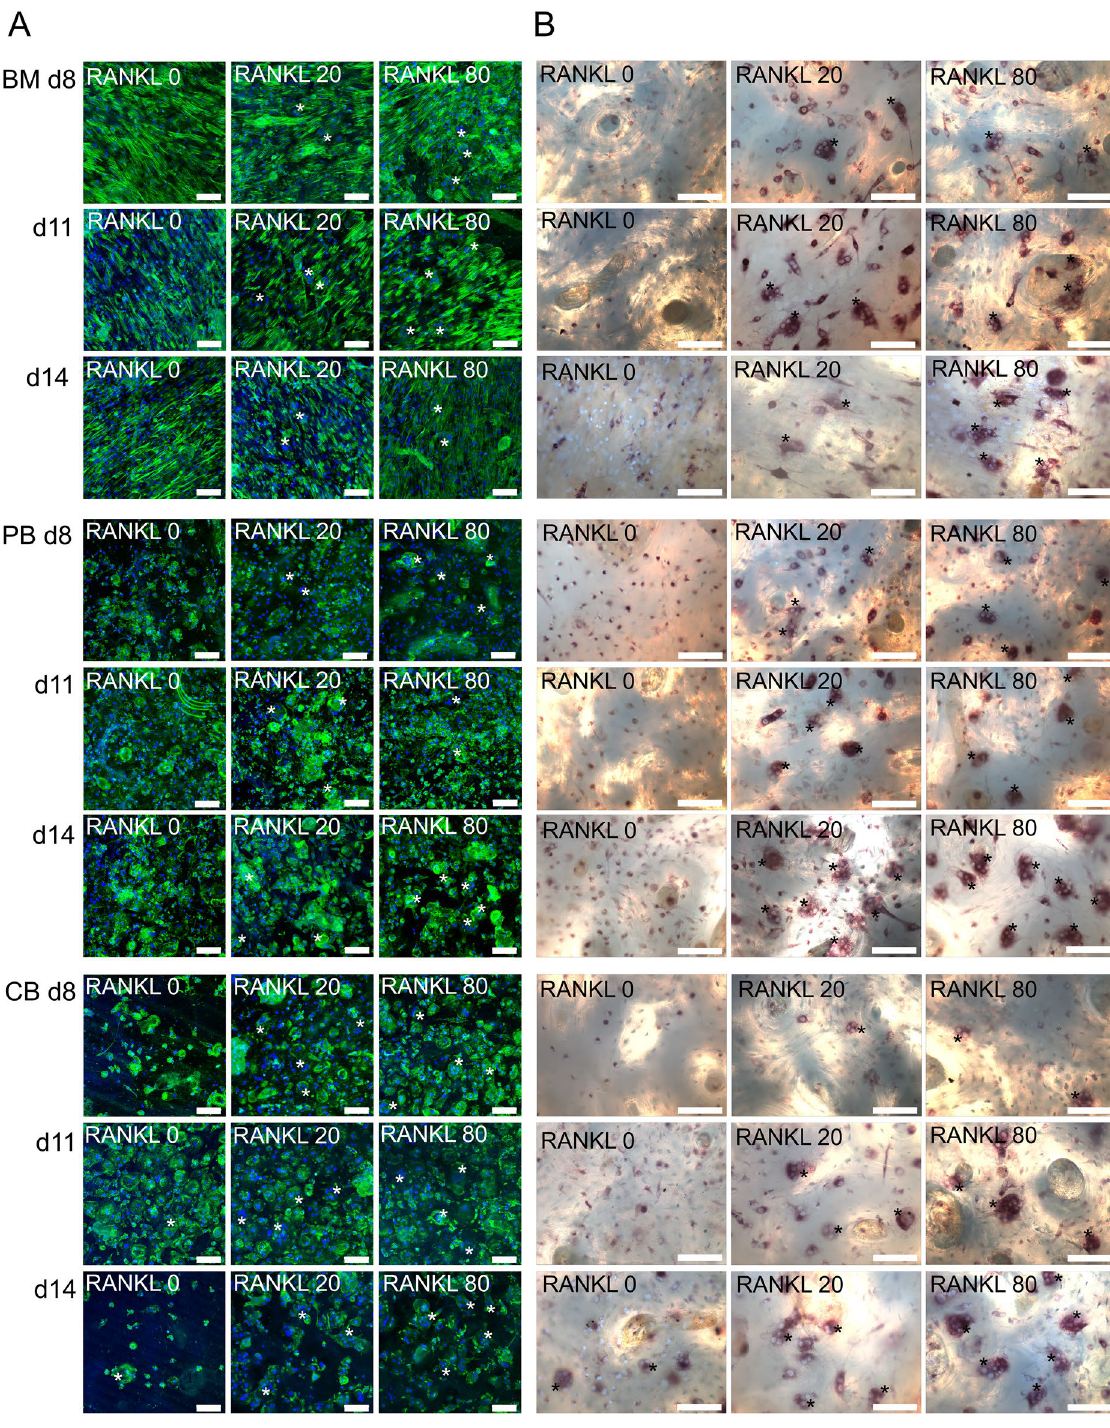
Figure 1. Multinuclear cell differentiation in BM, PB and CB cultures. ( A ) Confocal images of osteoclast cultures at time points d8, d11, and d14. The cells were cultured on human bone slices. The actin cytoskeleton was stained with Alexa 488-conjugated phalloidin (green) and nuclei were stained with Hoechst (blue). Images were taken with confocal microscope and 20 × objective (representative data from one patient). Multinuclear cells are marked with asterisk (*). ( B ) Combined light and fluorescence microscope images of osteoclast cultures at time points d8, d11, and d14. The cells were stained with Hoechst (blue) and acid phosphatase leukocyte kit to visualize TRACP (red). Images were taken with 20 ×